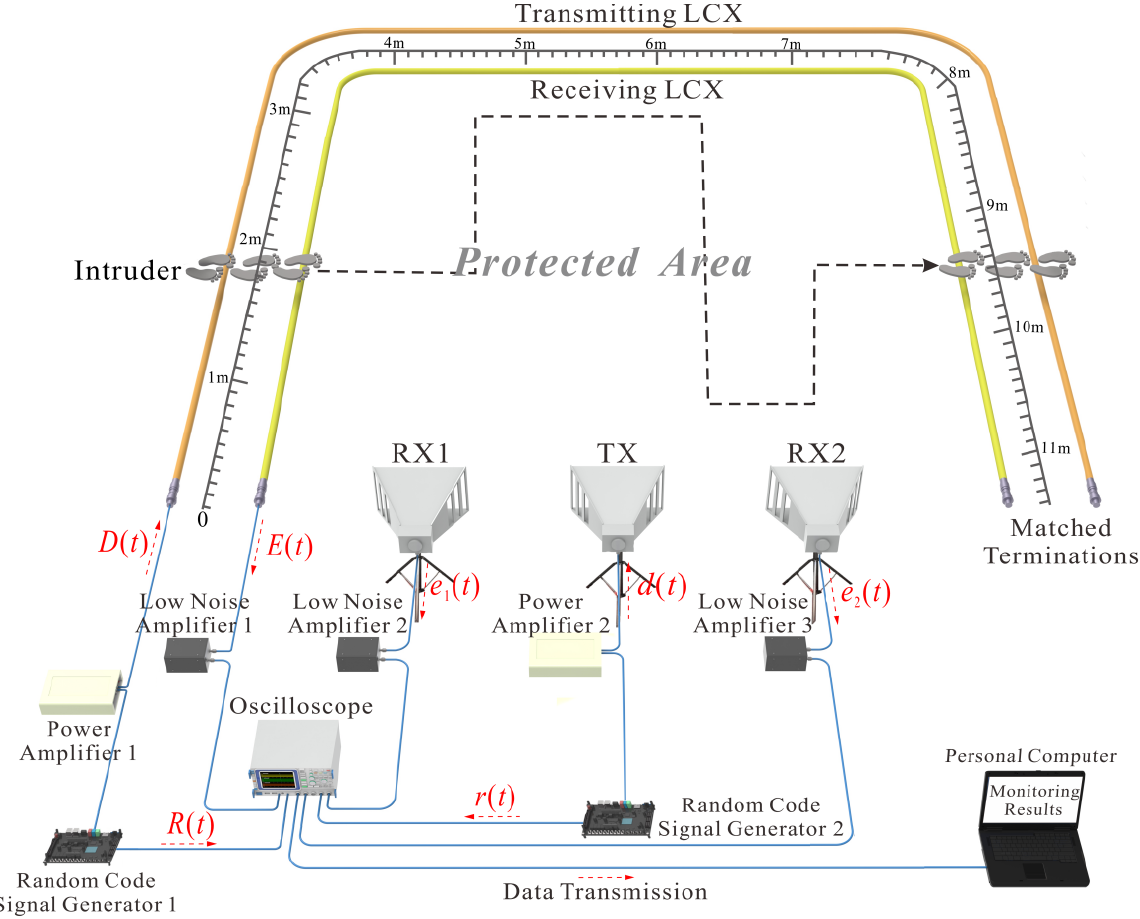
Figure 1. Experimental setup of the combined intrusion-detection sensing system.